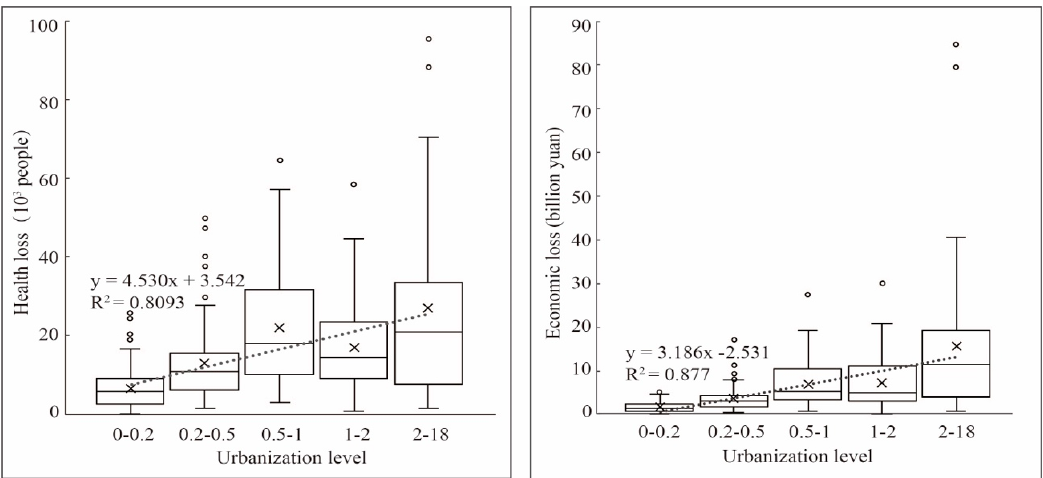
Figure 6. Correlation between urbanization level and PM 2.5 related health risks as well as economic loss. The ( left ) figure is health risks and the ( right ) one is economic loss. loss. The ( left ) figure is health risks and the ( right ) one is economic